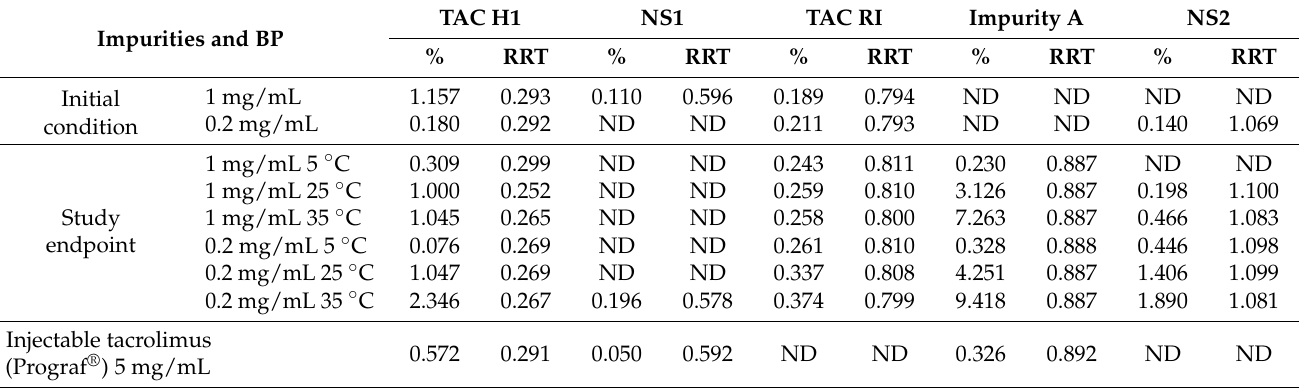
Table 4. Follow-up of the principal tacrolimus impurities and degradation (expressed as the ratio of the area of the peaks observed over the area of tacrolimus at the initial time and comparison with the impurities found in Prograf ® . NS: non-specified impurity; RRT: relative retention time, based on tacrolimus retention time, ND: not detected.